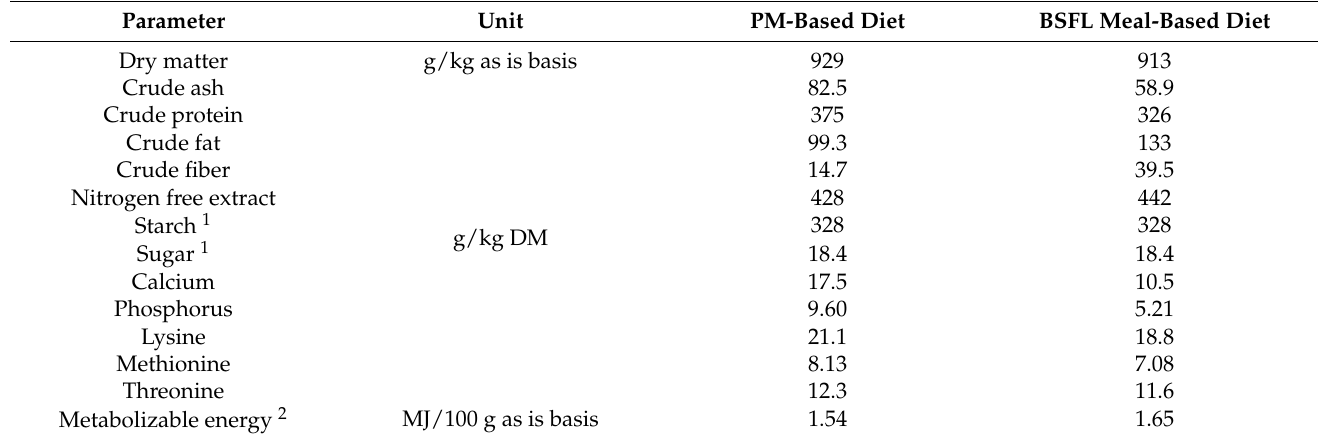
Table 5. Chemical composition of the experimental